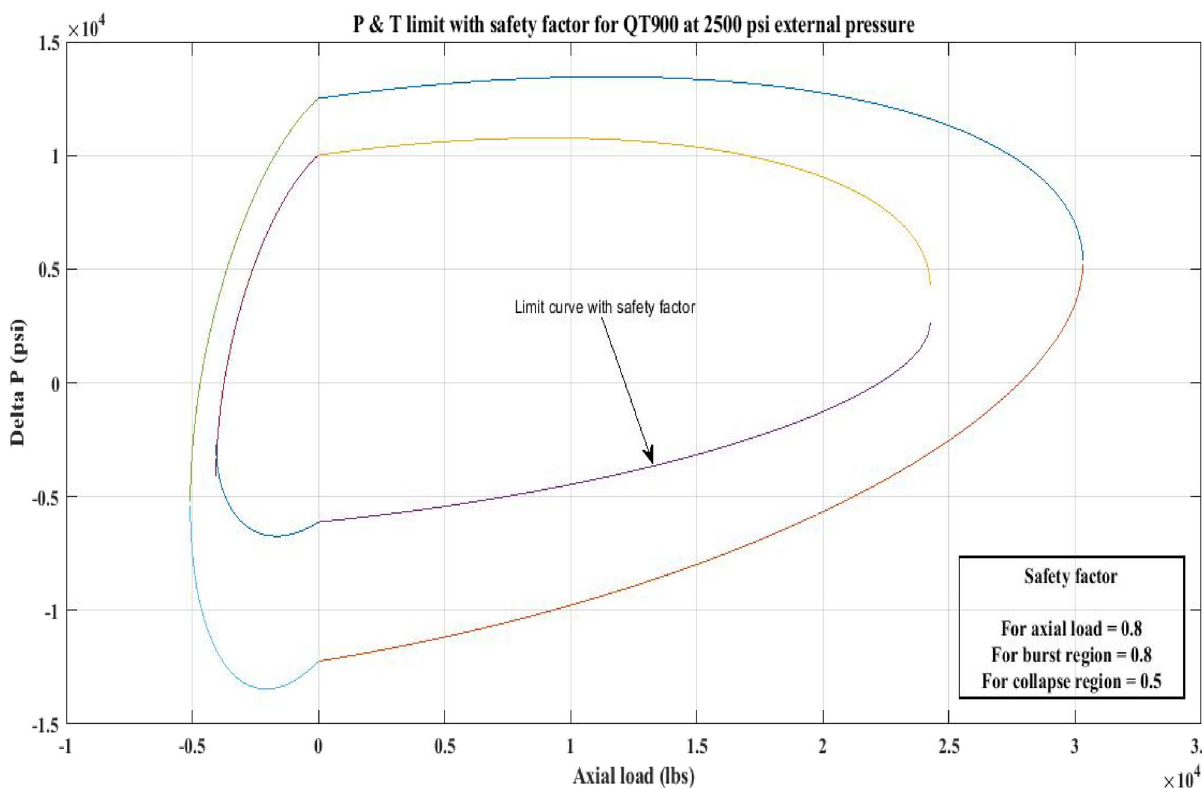
Figure 20. P and T limit with safety factor for QT 900 at 2500 psi P o .